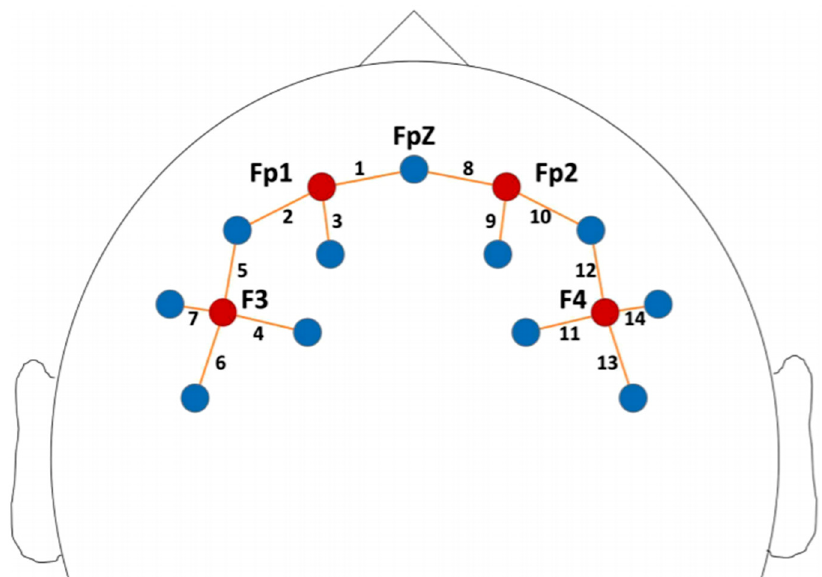
Figure 1. fNIRS optode localization. The probe center was positioned on Fpz and the lowest probe line was positioned along the Fp1–Fp2 line. Red circles: sources; blue circles: detectors; regions of interest: left prefrontal—source 1 (Fp1) and channels 1–3, right prefrontal—source 3 (Fp2) and channels 8–10, left frontal—source 2 (F3) and channels 4–7, and right frontal—source 4 (F4) and channels 11–14 (for further details about the fNIRS methodology used in this work, the reader is referred to Mauri and colleagues